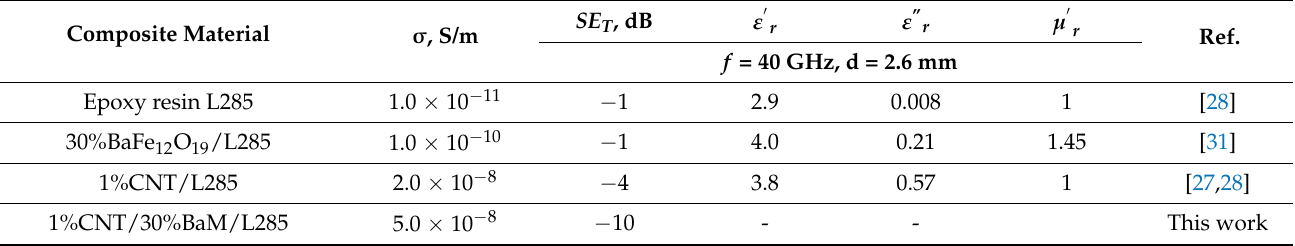
Table 1. Electrical conductivity, shielding efficiency, dielectric permittivity, and magnetic permeability for epoxy composites with various fillers. Composite Material σ , S/m